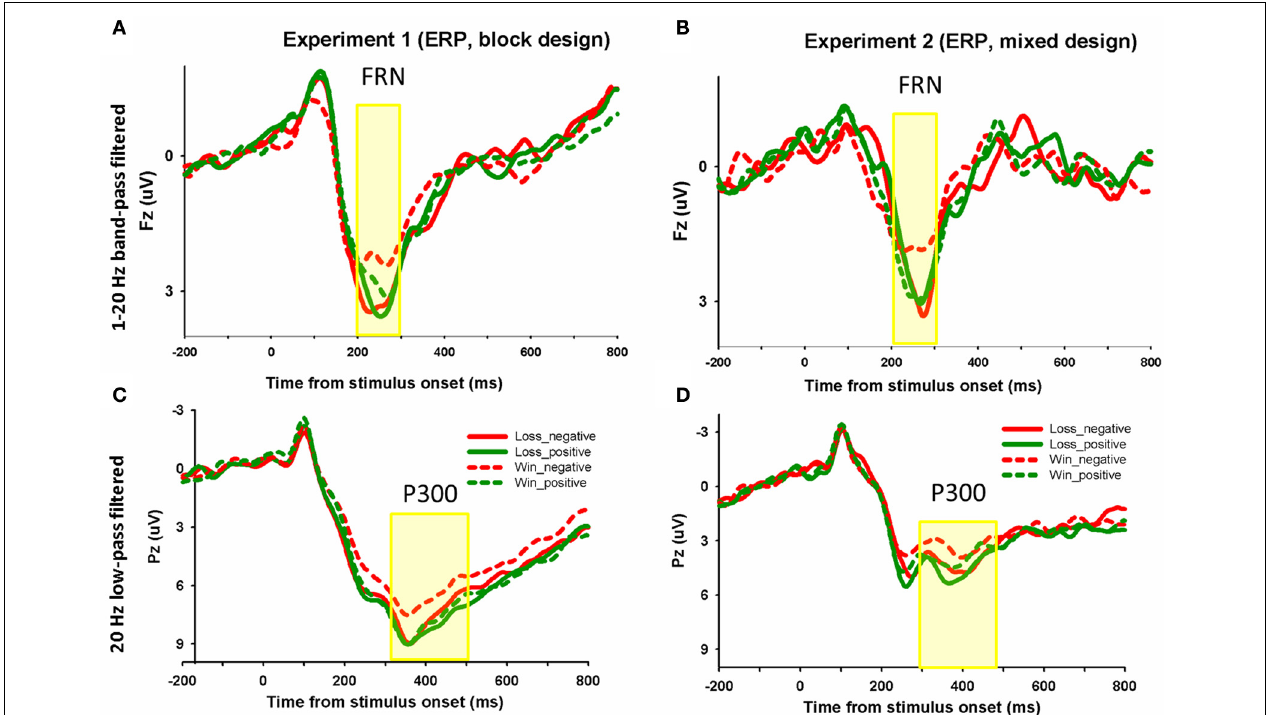
FIGURE 3 | The ERP grand-average waveforms. In Experiment 1 (A) and Experiment 2 (B) , grand-average waveforms from channel FZ using 1–20Hz band-pass filtered for four experimental conditions (win_positive, win_negative, loss_positive, loss_negative) were shown.